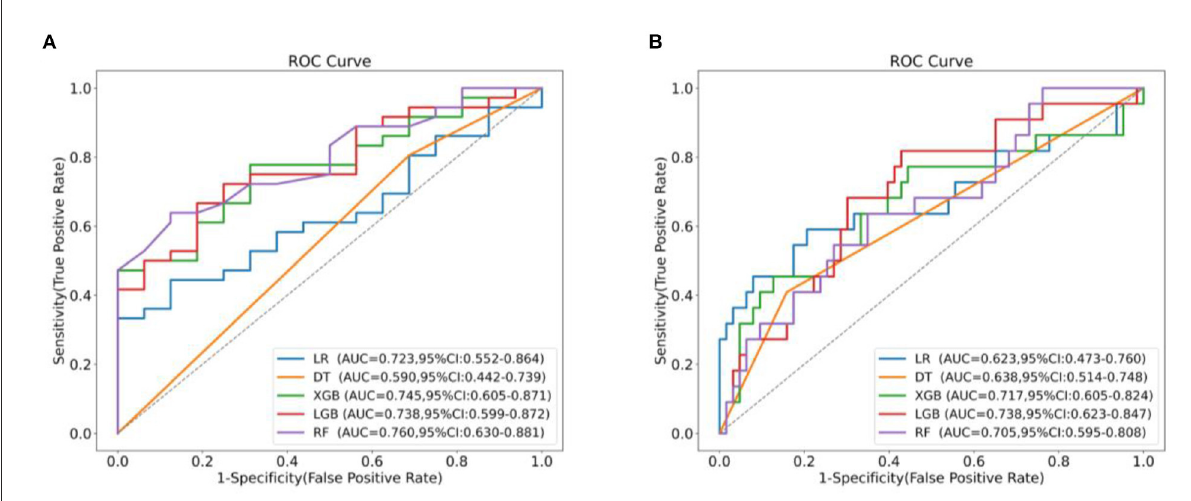
FIGURE4 AUC comparison between machine learning models. (A) Shows the ROC curves and AUC values of different models predicting post-operative AKI after Bootstrap 1,000 times in the TAAAD training set. (B) Shows the ROC curves and AUC values of different models predicting postoperative AKI after Bootstrap 1,000 times in the TBAAD training